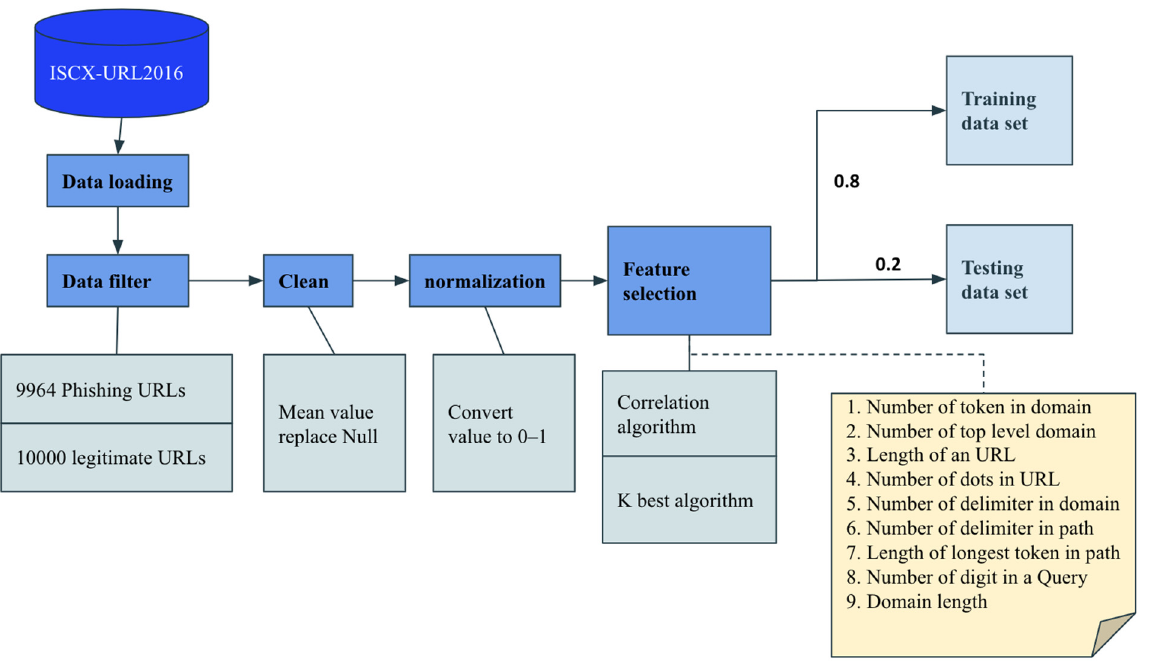
Figure 3. The data preparation process for the ISCX-URL-2016